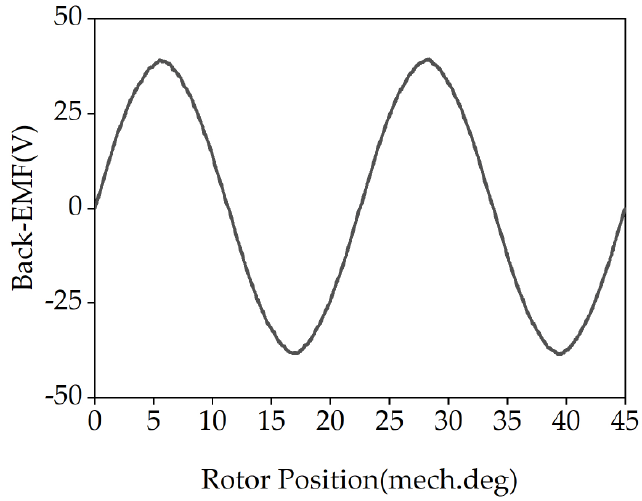
Figure 12. The measurement results of no-load back-EMF.